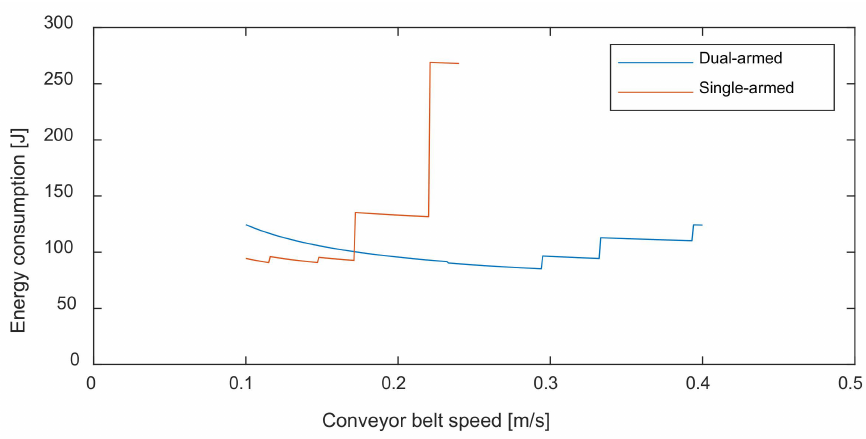
Figure 7. Total energy consumption for single and dual-arm robot pick-and-place operation with different conveyor-belt